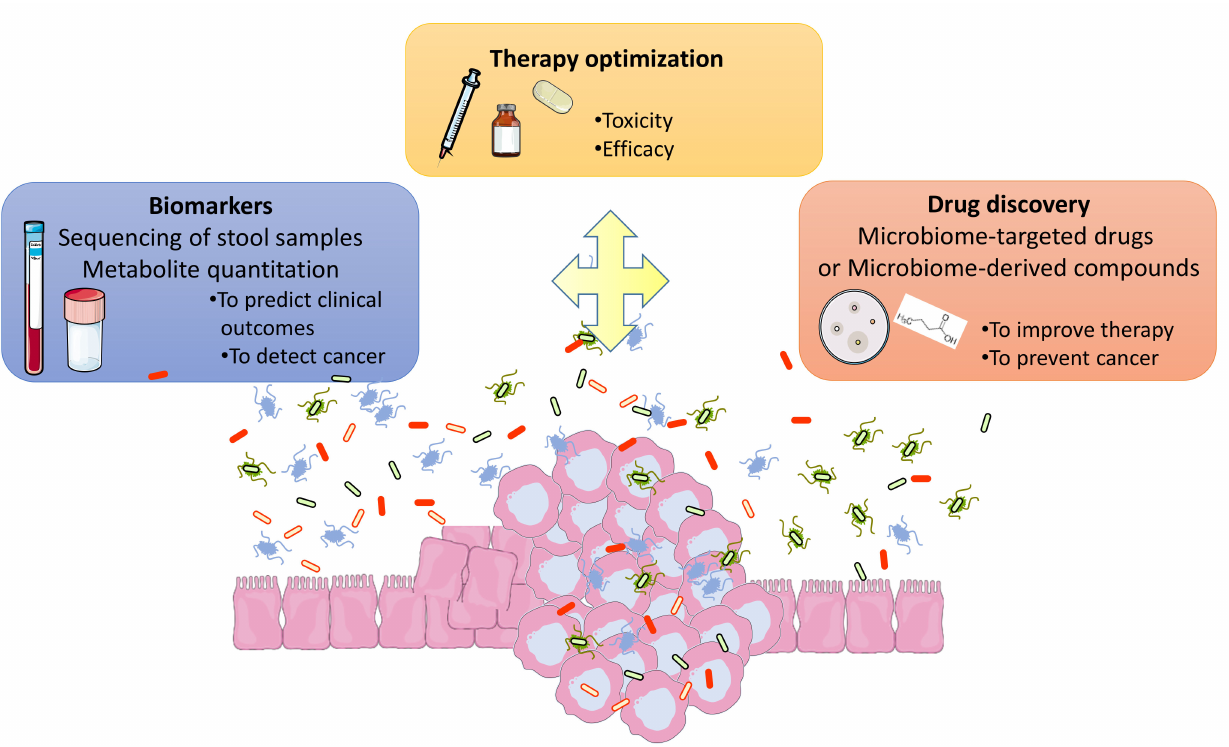
Figure 1. Intestinal microbiome for a better management of cancer patients. New biomarkers based on microbial com- position of the stool are emerging to predict clinical outcomes. Metabolites signatures and/or sequencing oral samples will also be developed as diagnostic or prognostic biomarkers. Studies about interactions between gut microbiota and treatments (surgery, chemotherapy, immunotherapy, radiotherapy) could allow to improve their efficacy and decrease some side effects (e.g., post-surgical complications, toxicity). Gut microbiota data could be use for the discovery of new and innovative therapeutic tools as small bioactive molecule which mimic benefic microbial effect or targeting procarcinogenic bacteria. Microbial intervention could be developed including prebiotics, probiotics, phages. Natural products and/or diet complementation can also be considered. These strategies will have to be adapted according to tumor characteristics and to the patient’s environment, lifestyle, host susceptibility and